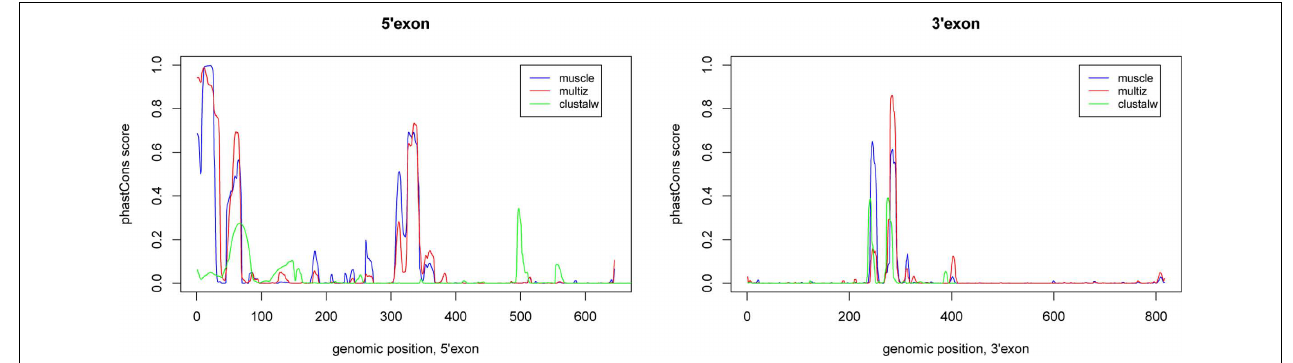
clustalw alignment based on our set of orthologs.The peaks are fairly similar, only clustalw slightly differs due to a higher alignment error rate resulting from the lack of consistency transformation or similar alignment refinement/improvement steps. Applied phastCons parameters: transitions 0.01, 0.01; rho 0.4.